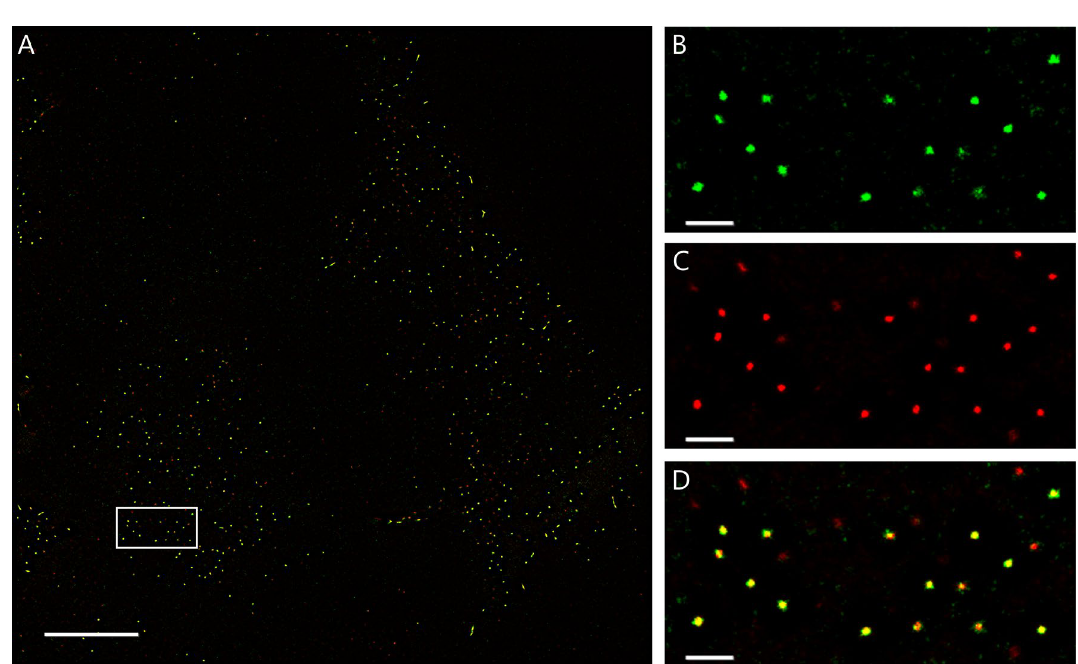
Figure 5. Here, the same two cells as in Fig. 4, are shown at super-resolution, visualized by SRRF microscopy with TIRF illumination and illustrate the positioning of the GZ19-32 (green, ( B ), CAIX antibody ( C ), and